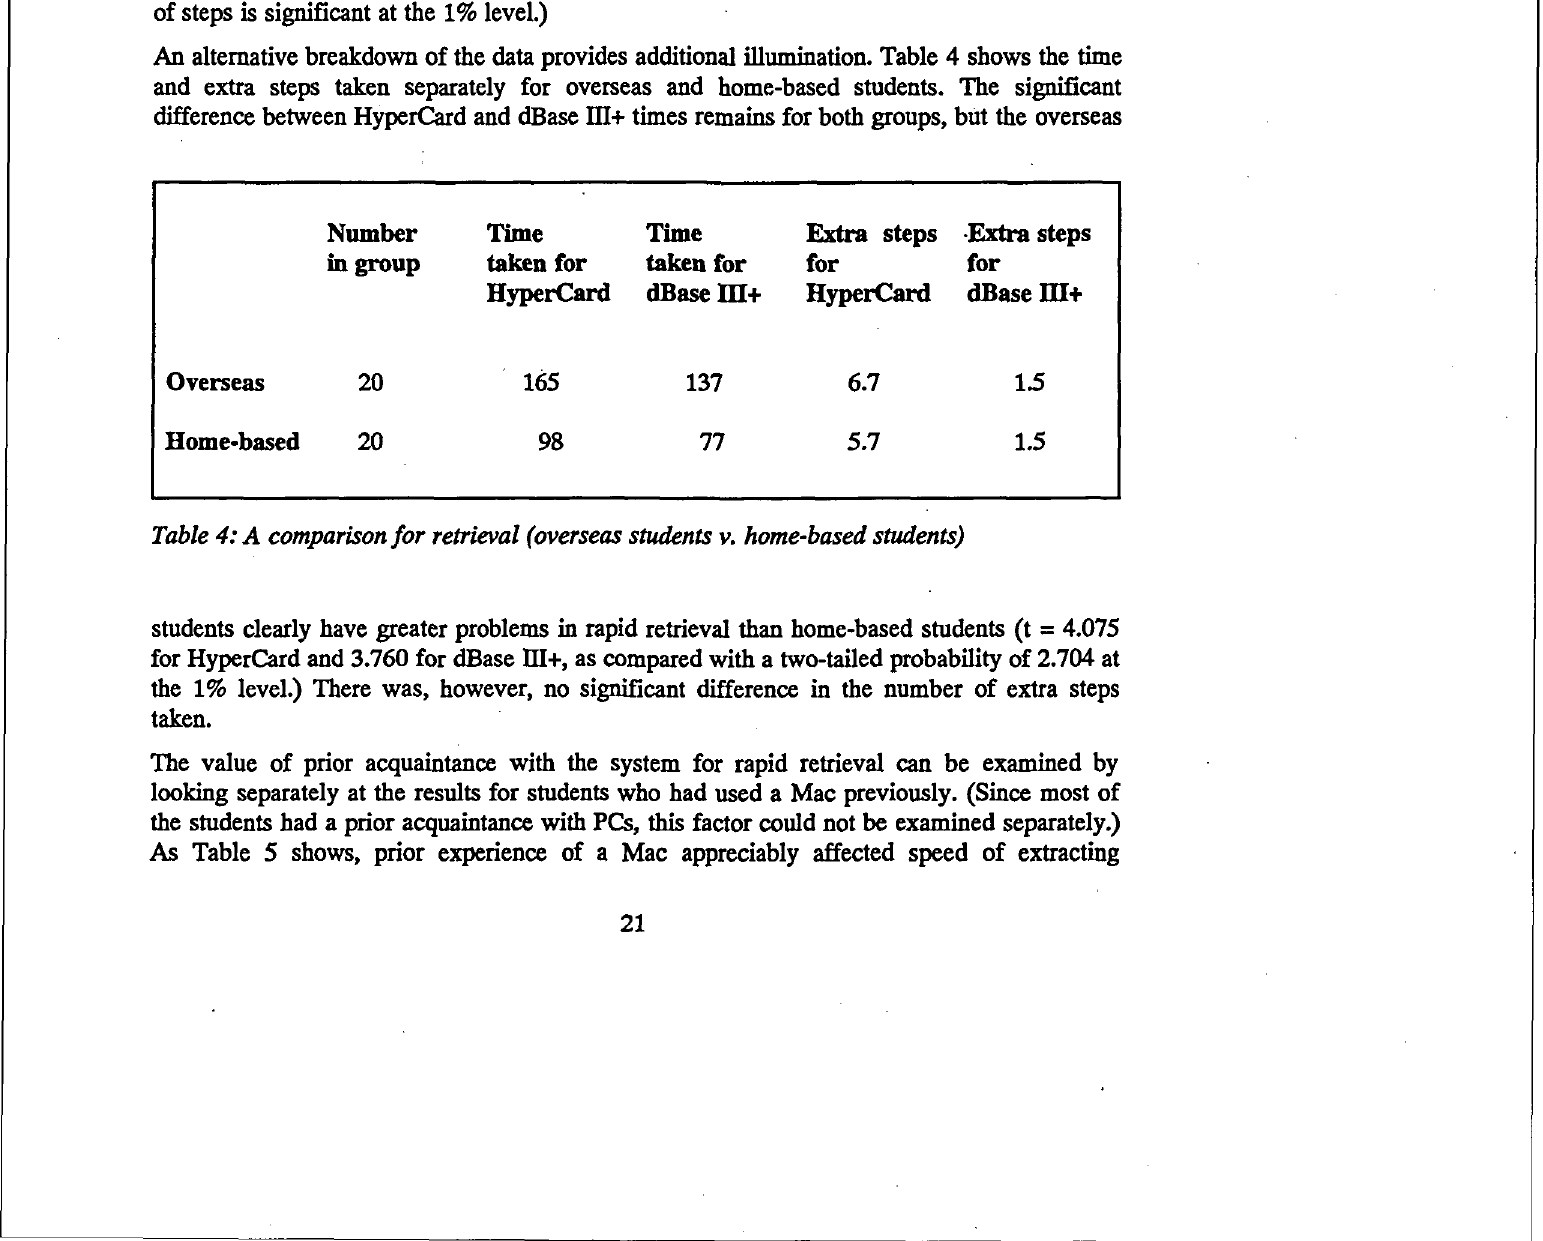
Table 3: A comparison of retrieval (Group A v. Group B)